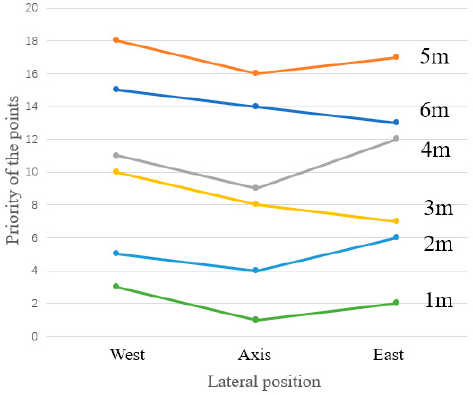
Figure 4. Priorities of each depth of the small office space.